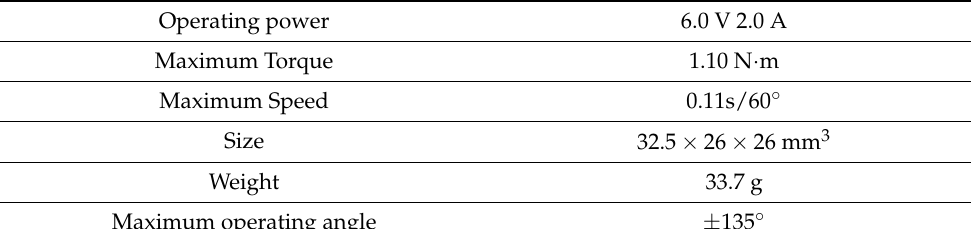
Table 2. Specification of servo motor used in